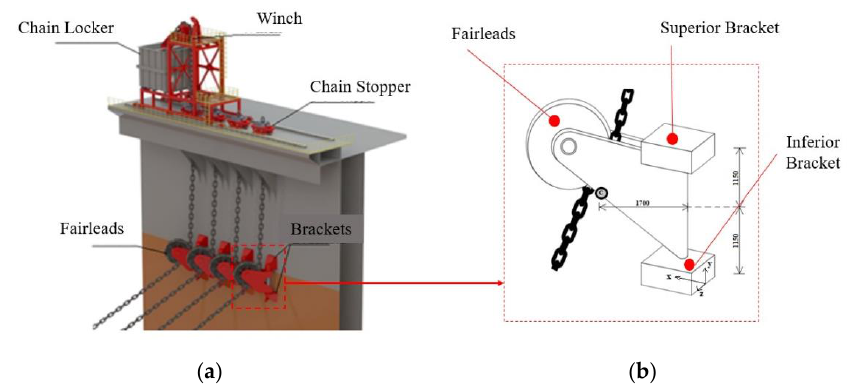
Figure 1. Illustration of a mooring system of an oil production platform vessel: ( a ) the full view of the mooring system mounted in the platform hull, ( b ) local view of the set fairlead-brackets